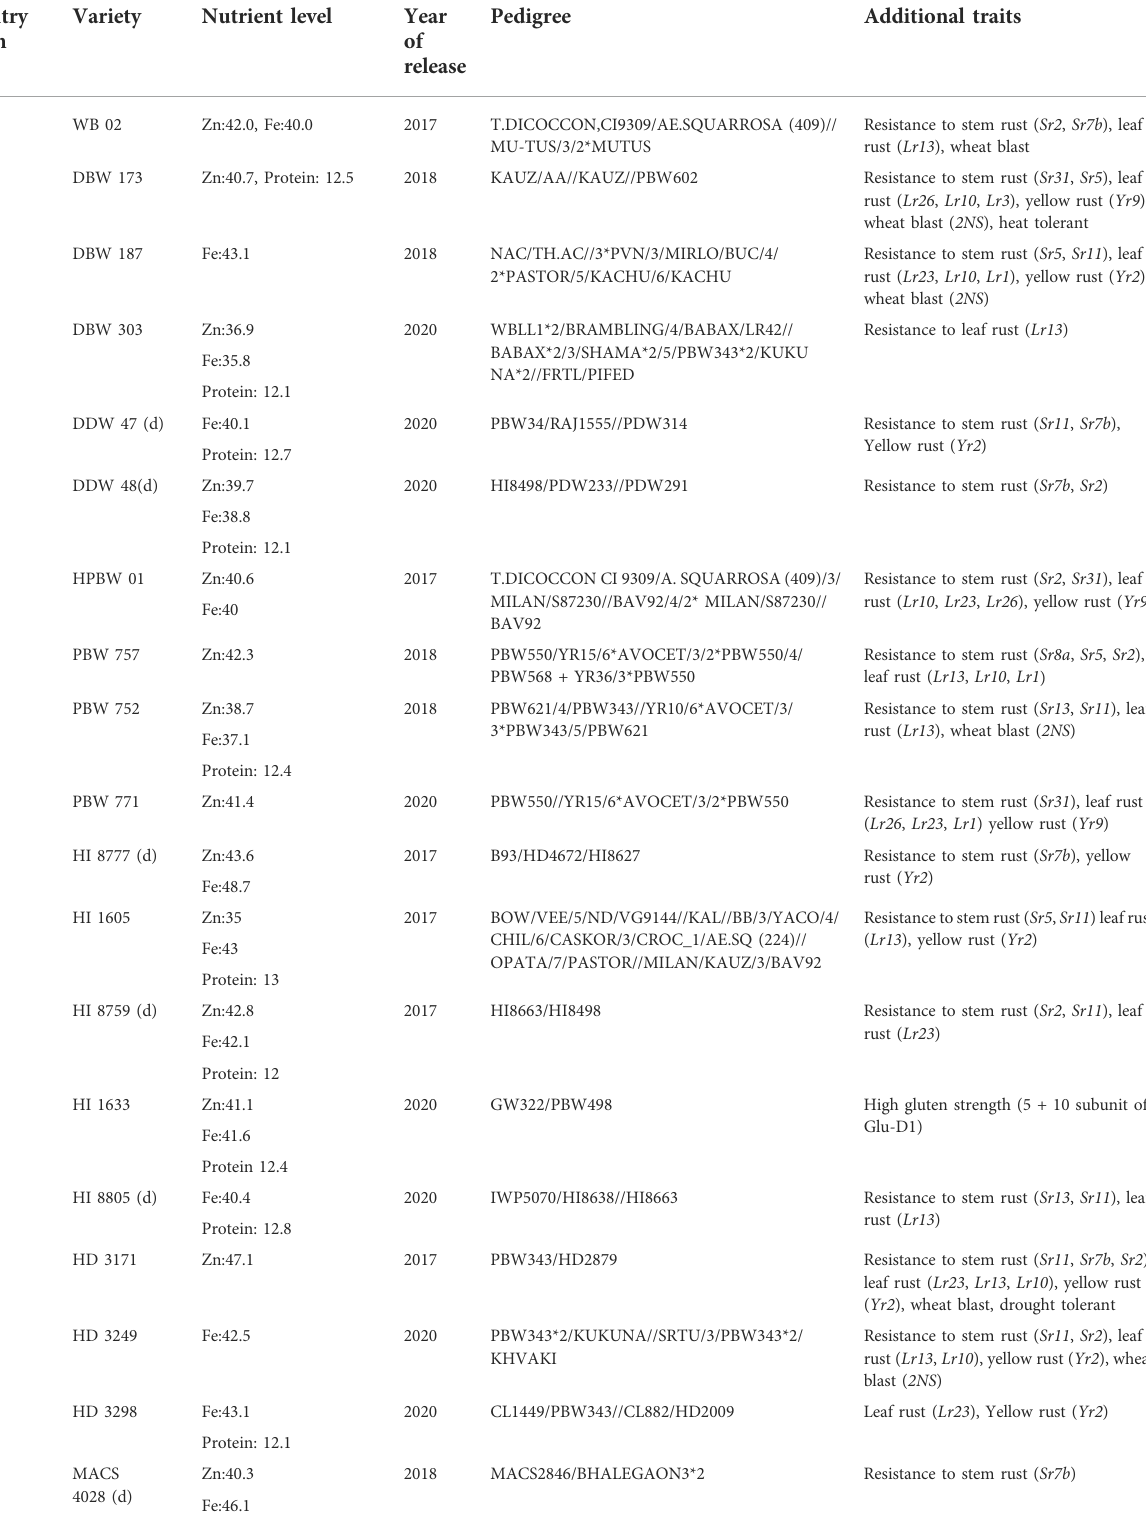
TABLE 3 List of bioforti fi ed wheat varieties released for commercial cultivation with their grain micronutrient level (ppm), protein content (%) and additional traits (modi fi ed from Gupta et al., 2022). Country Variety Nutrient level Year origin